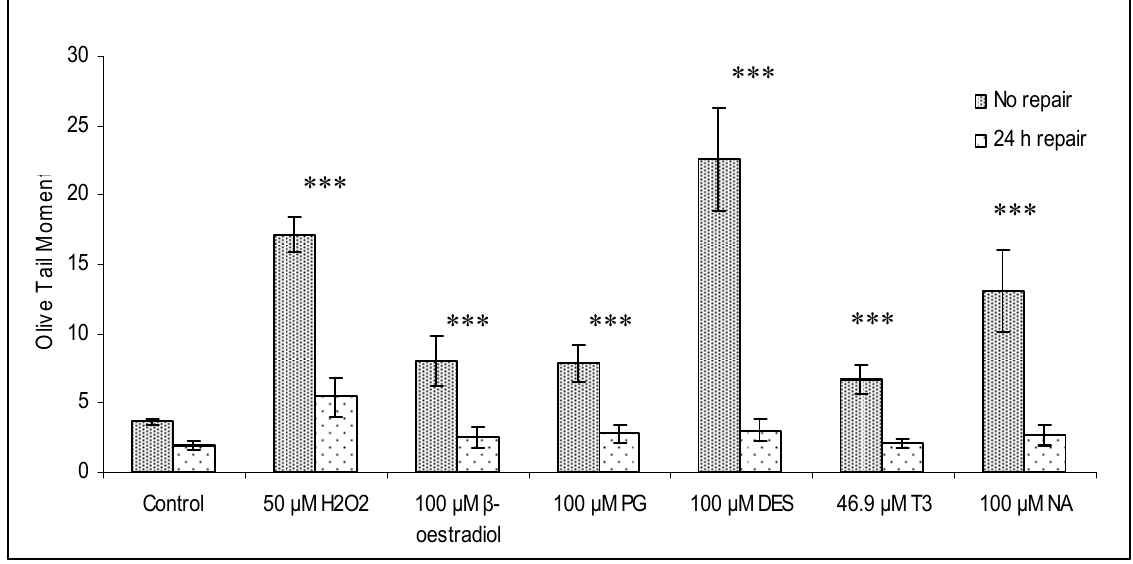
Figure 2. The Olive Tail Moment values f ο r fresh lymphocytes treated with oestrogenic compounds or Η Ο for 120 min and after 24 h repair in fresh medium. The mean of the 2 2 values obtained from 7 independent experiments are shown (n = 7 different donors). Average age is 27.57 ± 2.41. Normality of the data was evaluated with the Shapiro-Wilks test. Data were normally distributed. The Student’s T-test was applied. For statistical interpretation of the data, no repair versus repair for each of the oestrogenic compounds was compared. The levels of significance are included: n.s. not significant; *p ≤ 0.05; **p ≤ 0.01 and ***p ≤